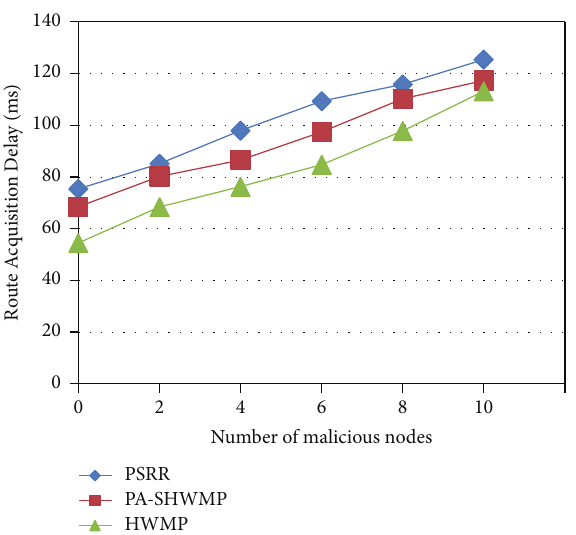
Figure 5: Average privacy entropy of RREQ versus number of malicious nodes.